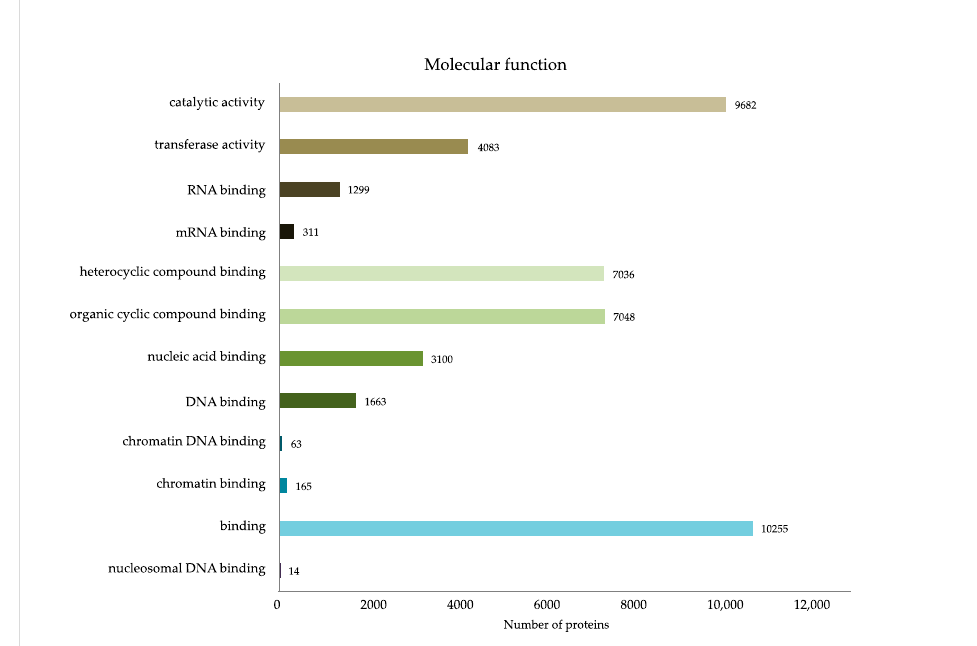
Figure 3. GO classification of the DEPs by molecular functions.